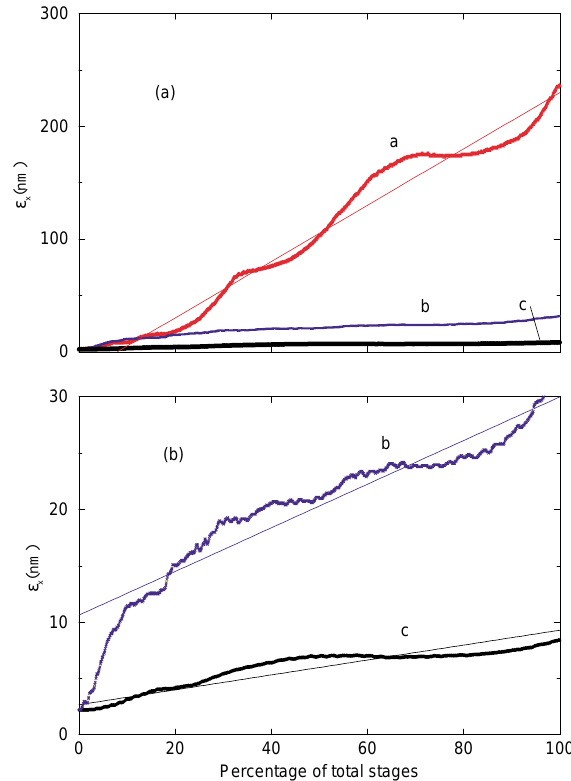
FIG. 12. (Color) The emittance degradation for three cases of the horn model. Curve ( a ), c (cid:1) 0.15 rad. Curve ( b ), c (cid:1) 0.04 rad. Curve ( c ), c (cid:1) 0.04 rad and d c (cid:1) 0.0001 rad.